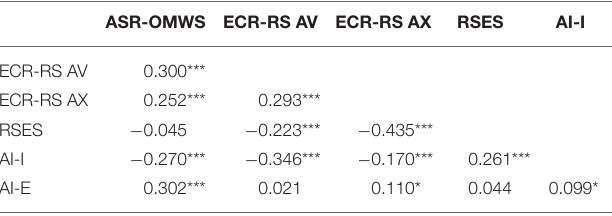
TABLE 2 | Associations of measured variables; the results of Pearson’s correlations for the older subsample ( n = 429).